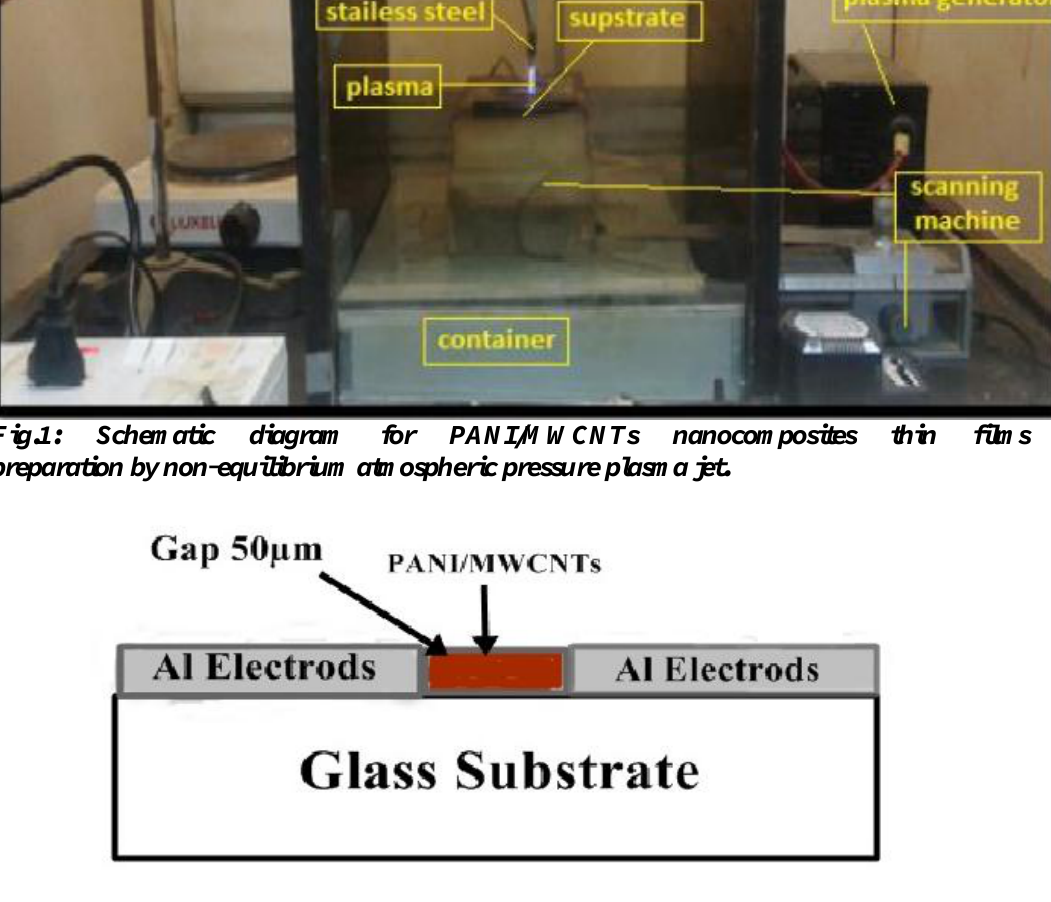
Fig.2: Schematic diagram of the